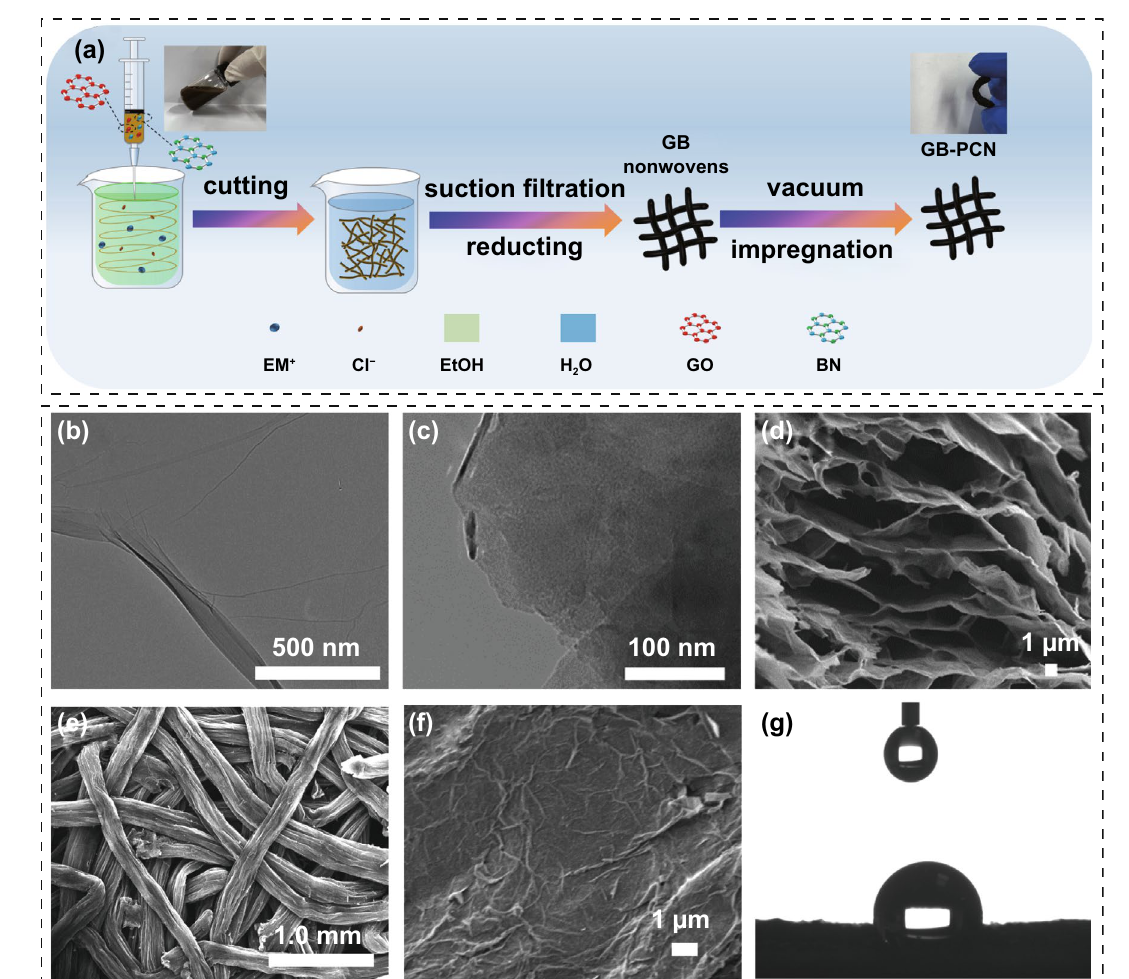
Fig. 1 Schematic diagram of the preparation process and structural characterizations for GB-PCN. a Schematic illustrating the fabrication of GB-PCN nonwoven. Inset images are the photographs of GO-BN spinning solution (left) and GB-PCN (right). TEM images of b GO nanosheets and c BN nanosheets. d Cross-sectional SEM image of a GB fiber. e , f Top-view SEM images of GB-PCN. g Photograph of the contact angle measurement of